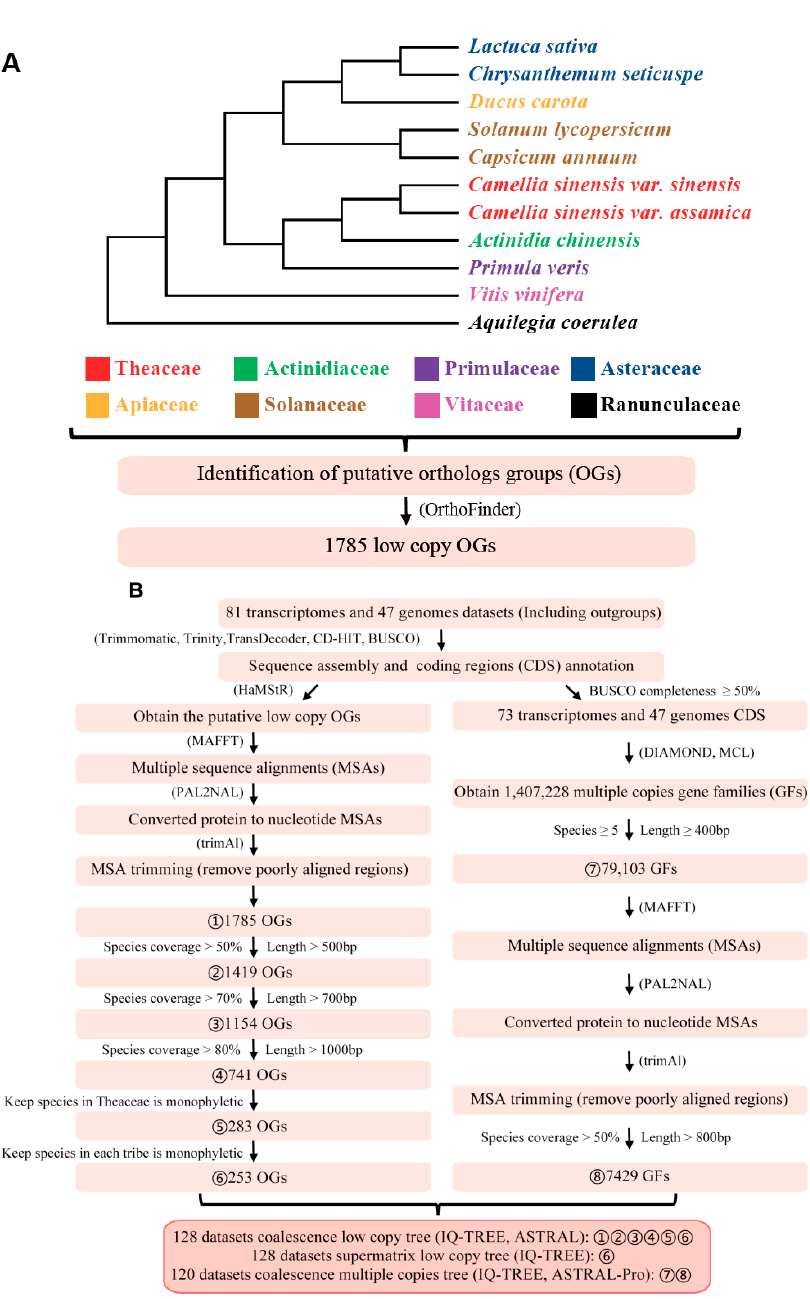
Figure 1. The flowchart of identification and filtration of low-copy nuclear gene sets: ( A ) The flowchart for the identification of low-copy orthologous groups. ( B ) The technical flowchart of phylogenetic tree reconstruction and nuclear genes filtration in Theaceae.